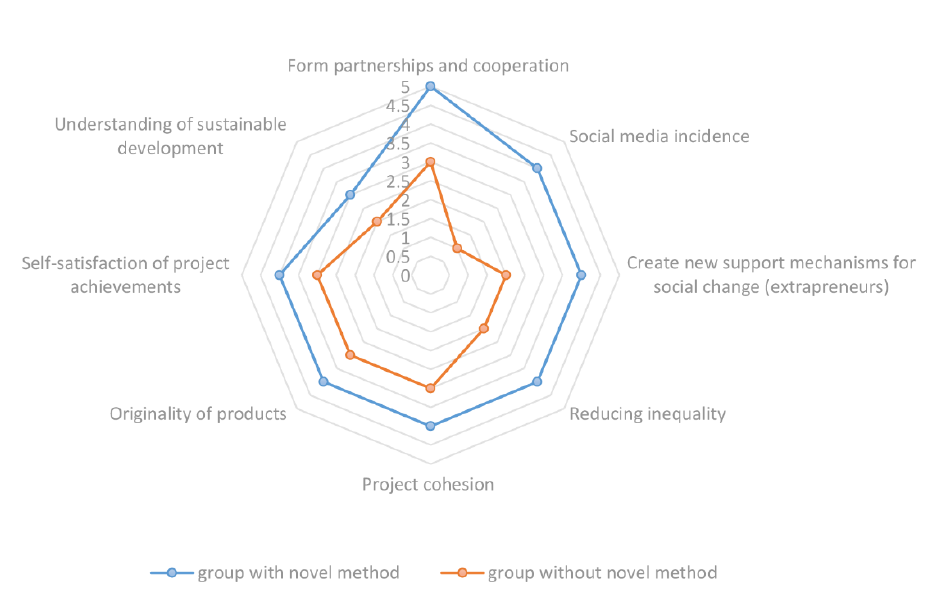
Figure 6. Assessment of the potential of the method for social innovation.